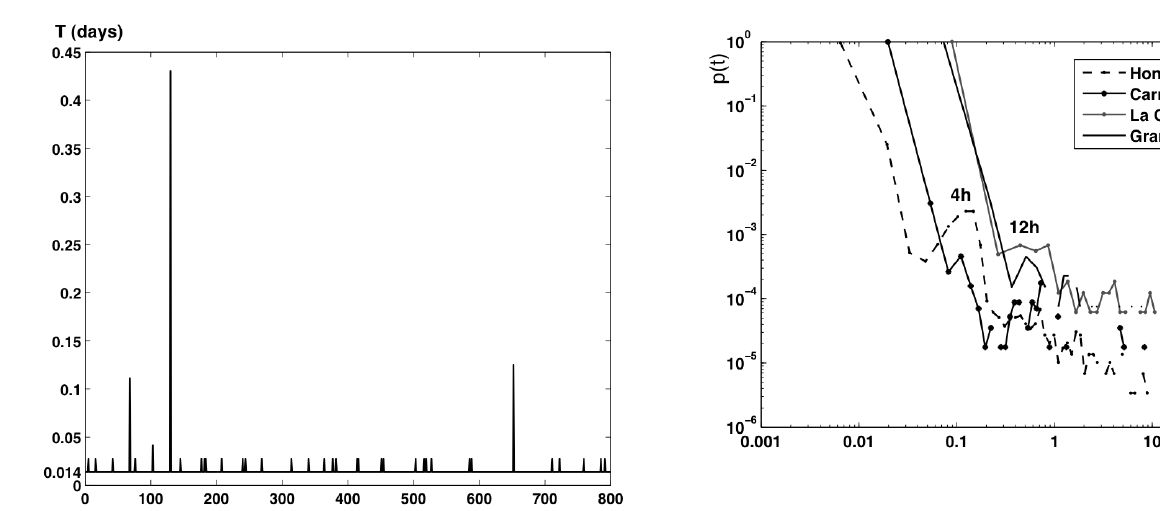
Fig. 3. A portion of 800 successive void intervals for the Marel Carnot series. This shows the stochastic aspect of the distribution of these missing values, and the many scales involved.